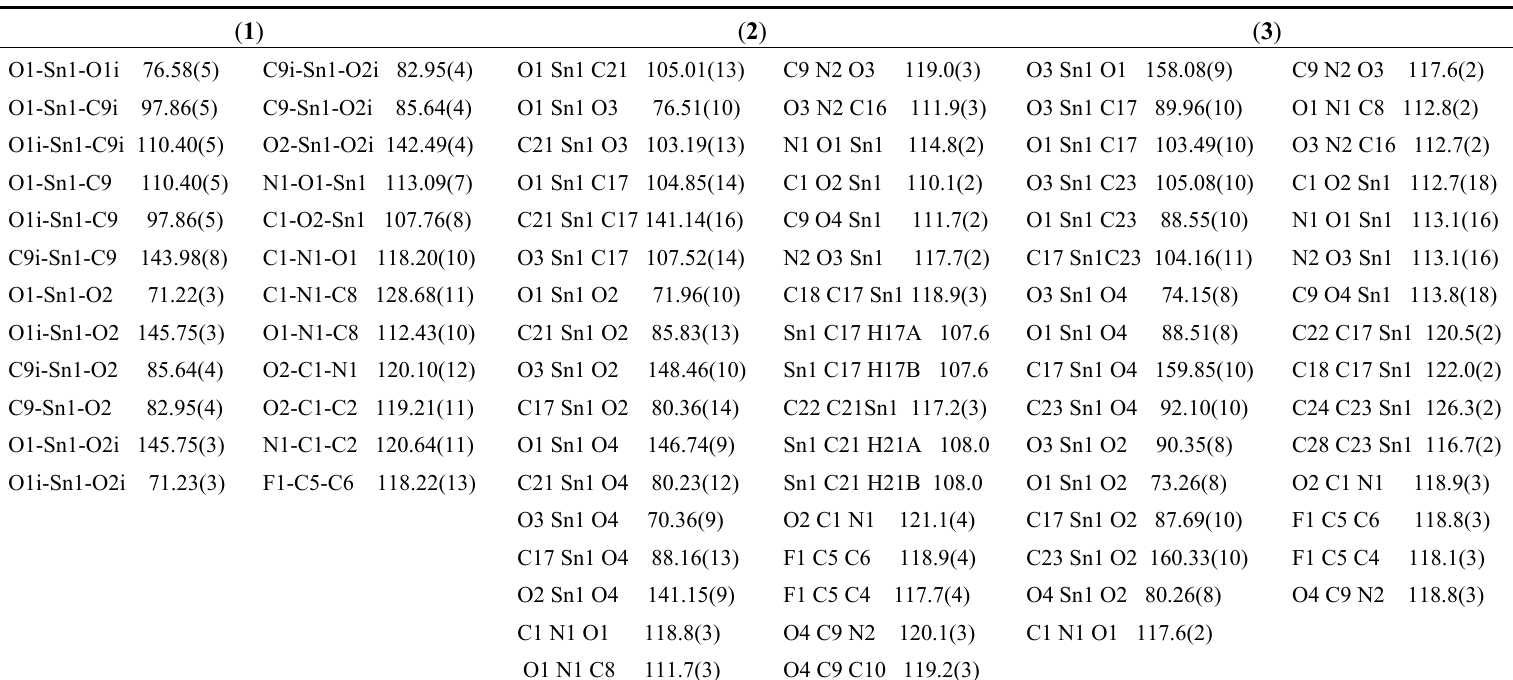
Table 2. Selected bond angles (deg) of the complexes ( 1 ), ( 2 ) and ( 3